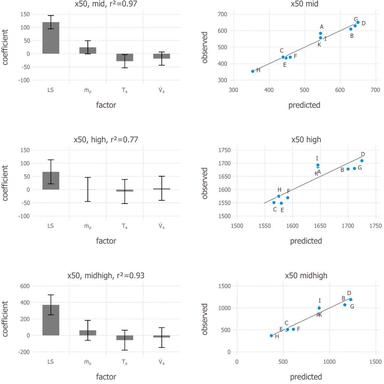
Coefficient and observed vs. predicted plots for x50 of mid, high and mid + high sieve fractions.